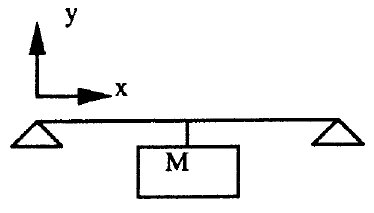
Fig. 1. Large mass method for a simply supported beam.